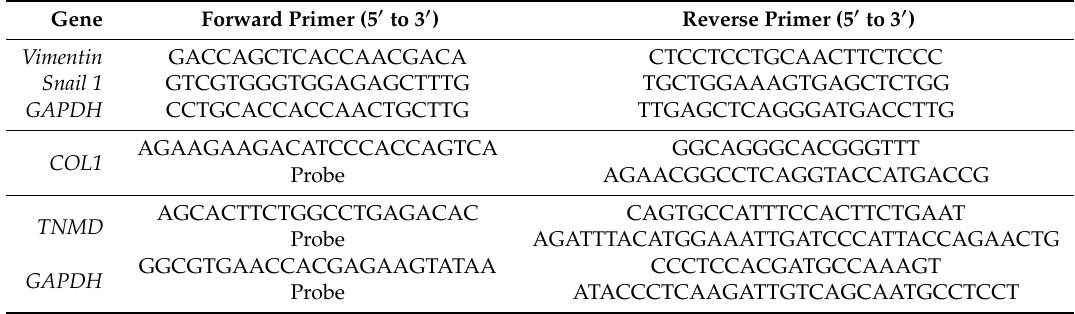
Table 2. Details on primers and probe